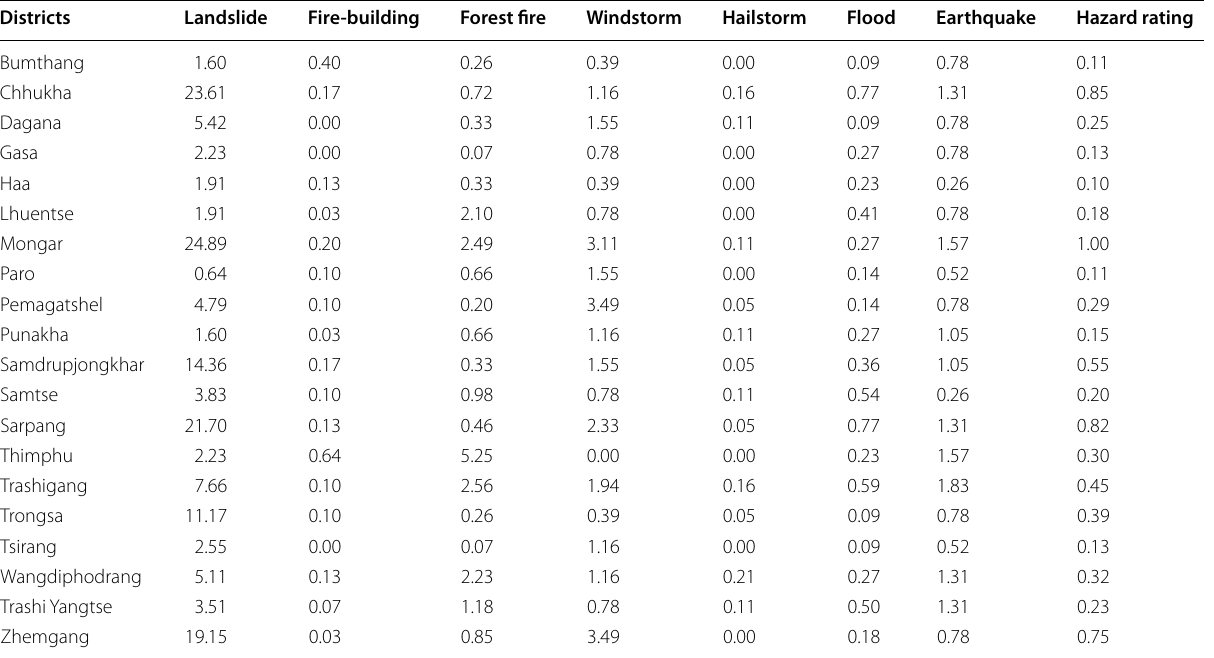
Table 8 Implementation of weights, hazard score aggregation and multi-hazard level rating Districts Landslide